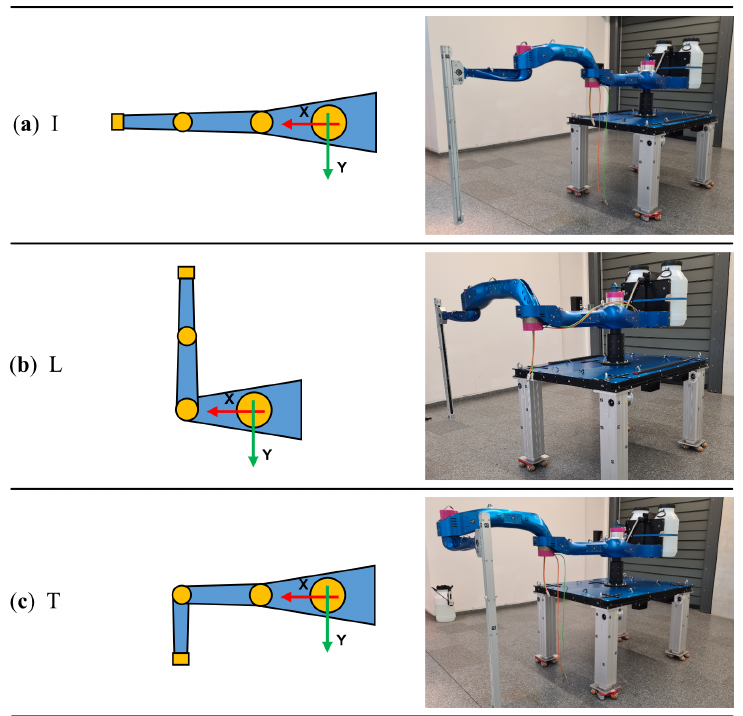
Figure 2. Robotic arm measuring positions: ( a ) Position “I”, ( b ) Position “L”, ( c ) Position